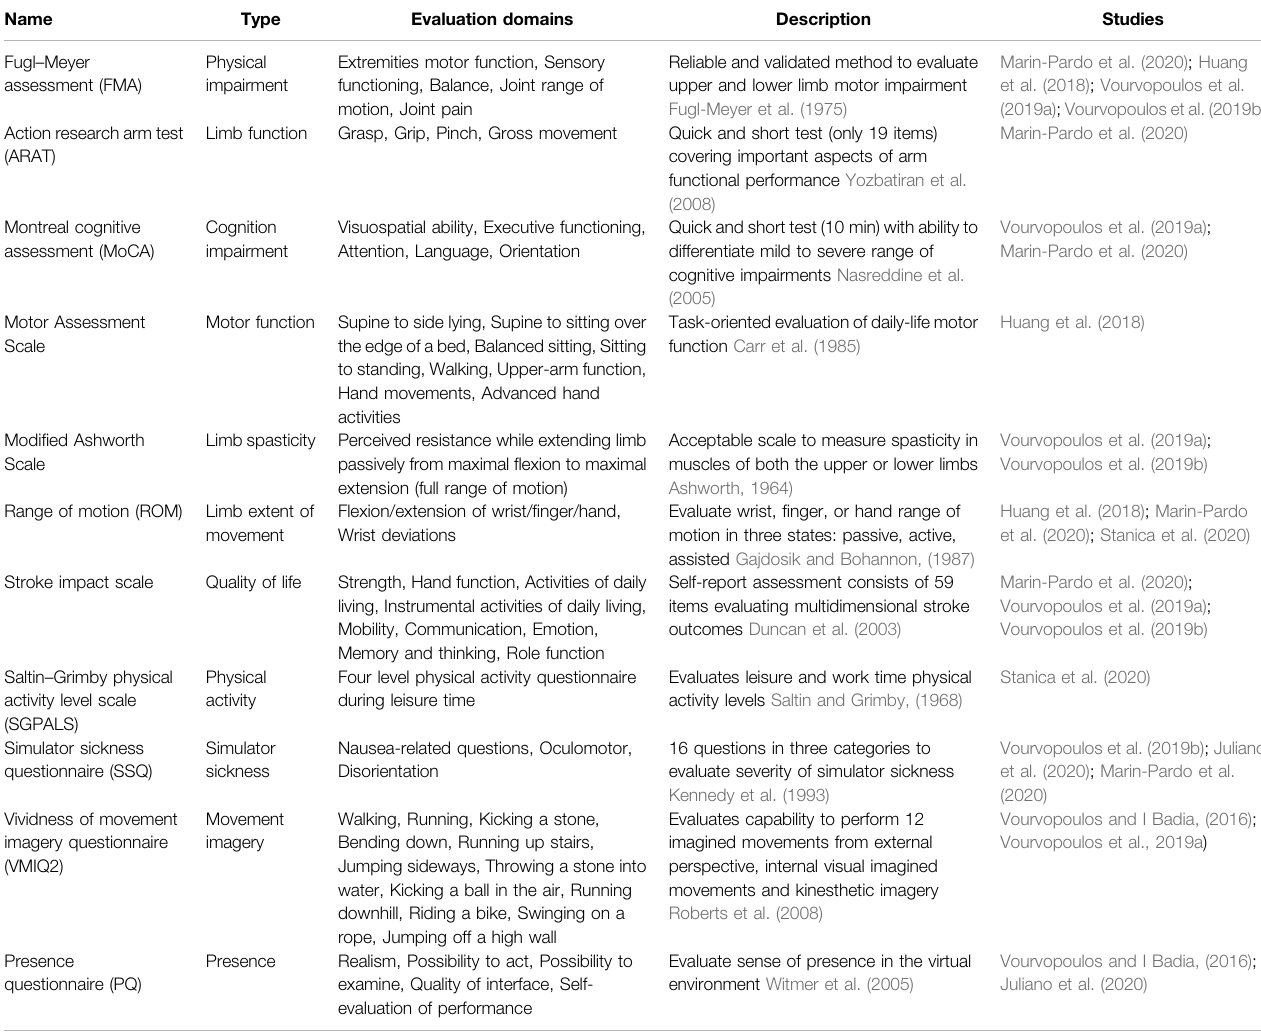
TABLE 5 | Frequently used clinical measurements and